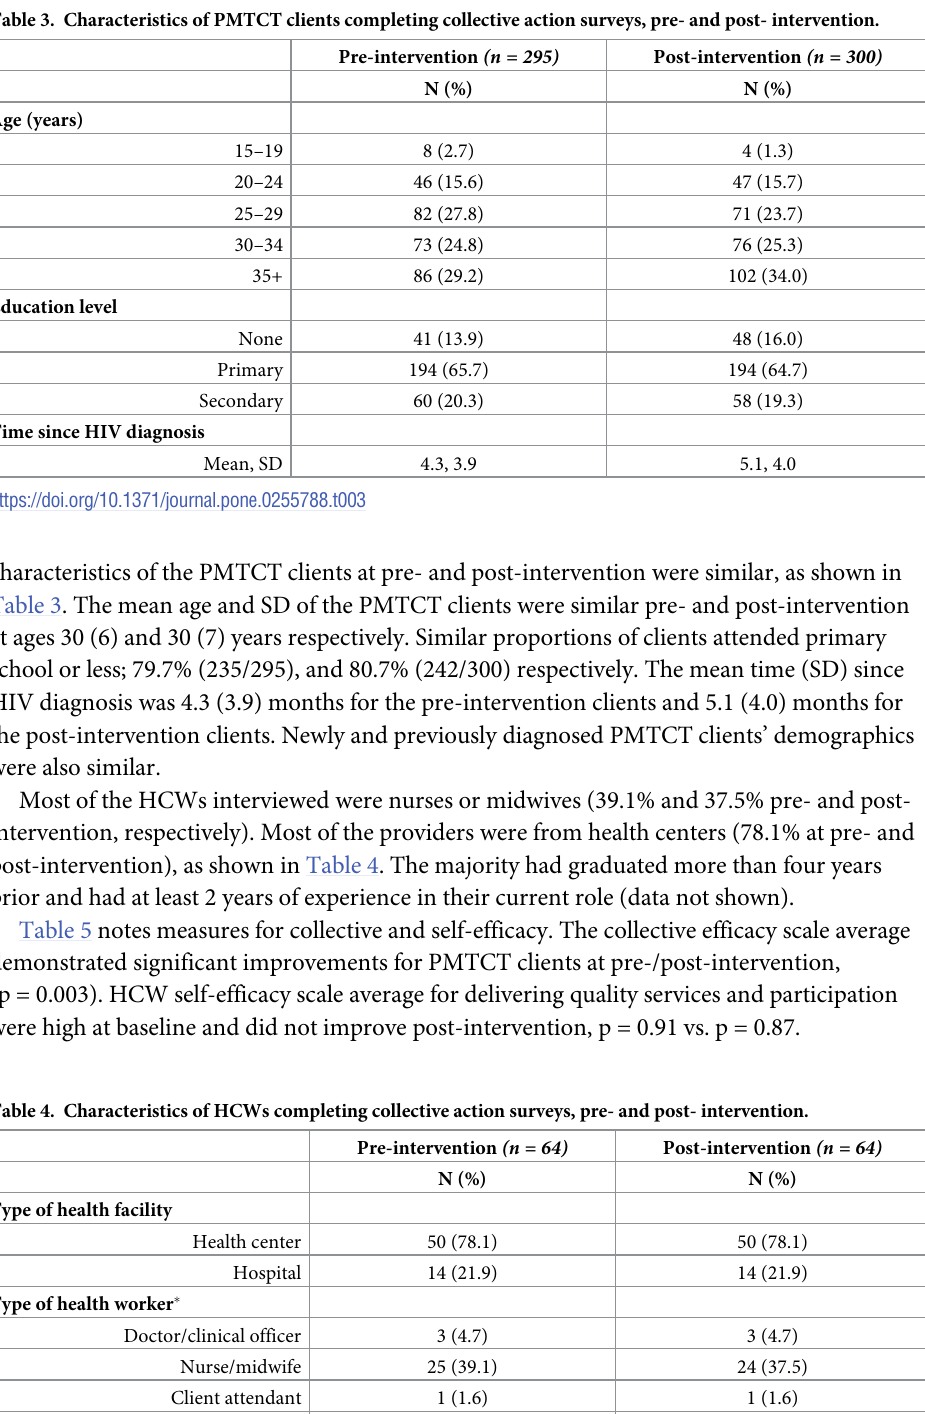
Table 3. Characteristics of PMTCT clients completing collective action surveys, pre- and post- intervention.